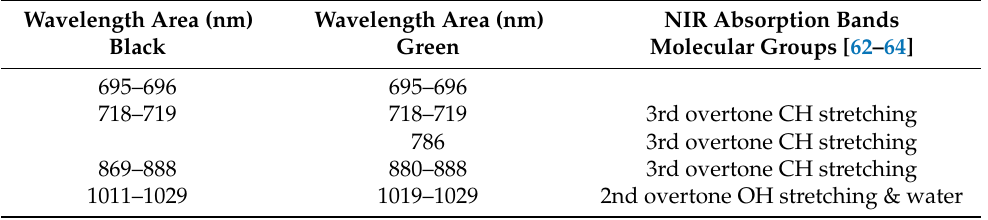
Figure 2. The smoothed ( a ) and normalized ( b ) NIR spectra of L-fucose tablet, L-proline tablet, and pure water. Table 3. Wavelength areas of L-fucose solutions that were recognized to have a systematic order from F1 → F2 → F3 → F4 to water were marked black. The wavelength areas where the solutions were in order from F1 → F2 → F3 to F4 or F1 → F2 → F3 to water were marked green. The corresponding molecular groups are named on the right. Wavelengths under 680 nm belong to the UV-VIS region and are not of interest in this